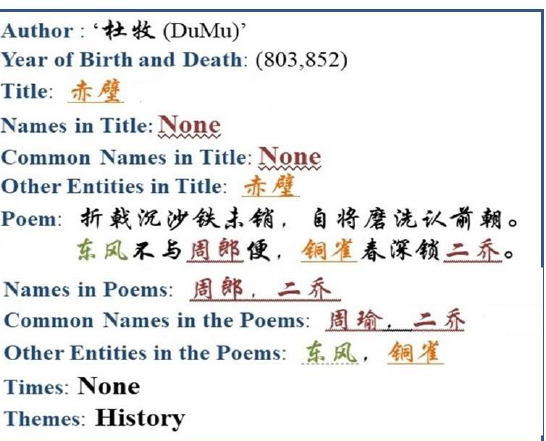
Figure 3. An example from 20 poets from the Tang Dynasty. Different types of named entities are represented by different colors and symbols: red for names, yellow for location, and green for literary quotation.